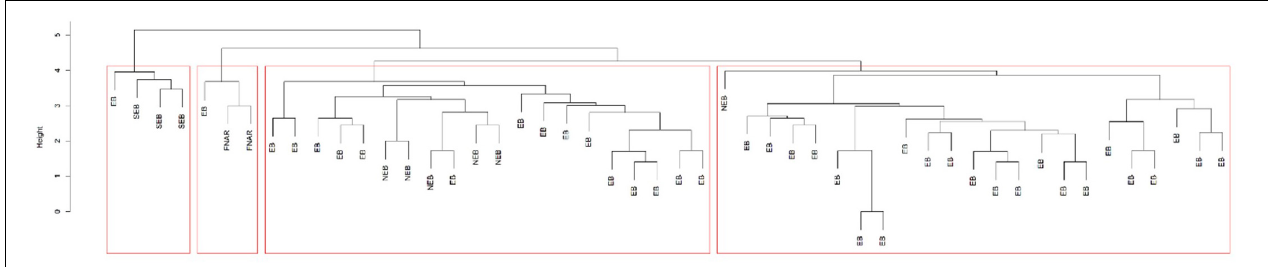
FIGURE 4 | Dendrogram showing dissimilarity among fishers of the “eastern octopus” Callistoctopus furvus in the marine ecoregions of the Brazilian coast. EB, eastern Brazil; FNAR, Fernando de Noronha and Atol das Rocas; NEB, northeastern Brazil; SEB, southeastern Brazil.